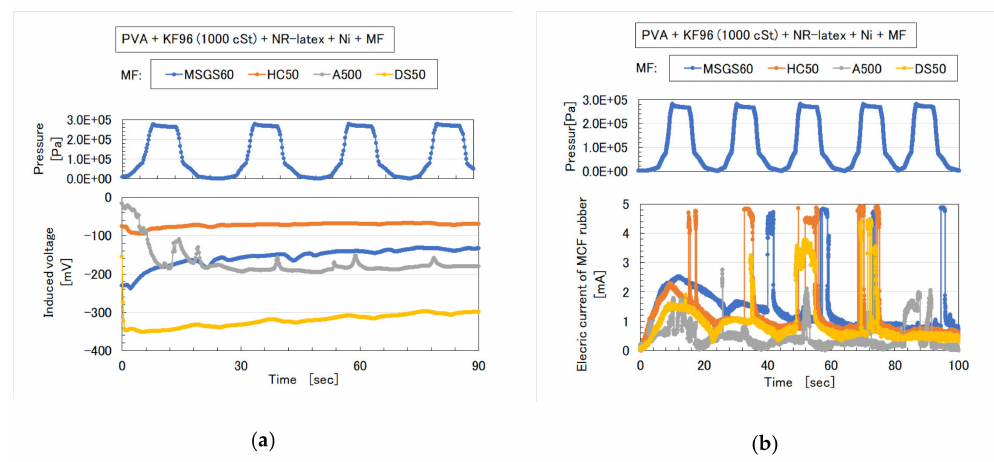
Figure 14. Induced voltage and electric current as piezo-resistivity of MCF rubber with KF96 and water-insolubleMFtorepeatapplicationofpressureinFigure6: ( a )piezo-electricity; ( b